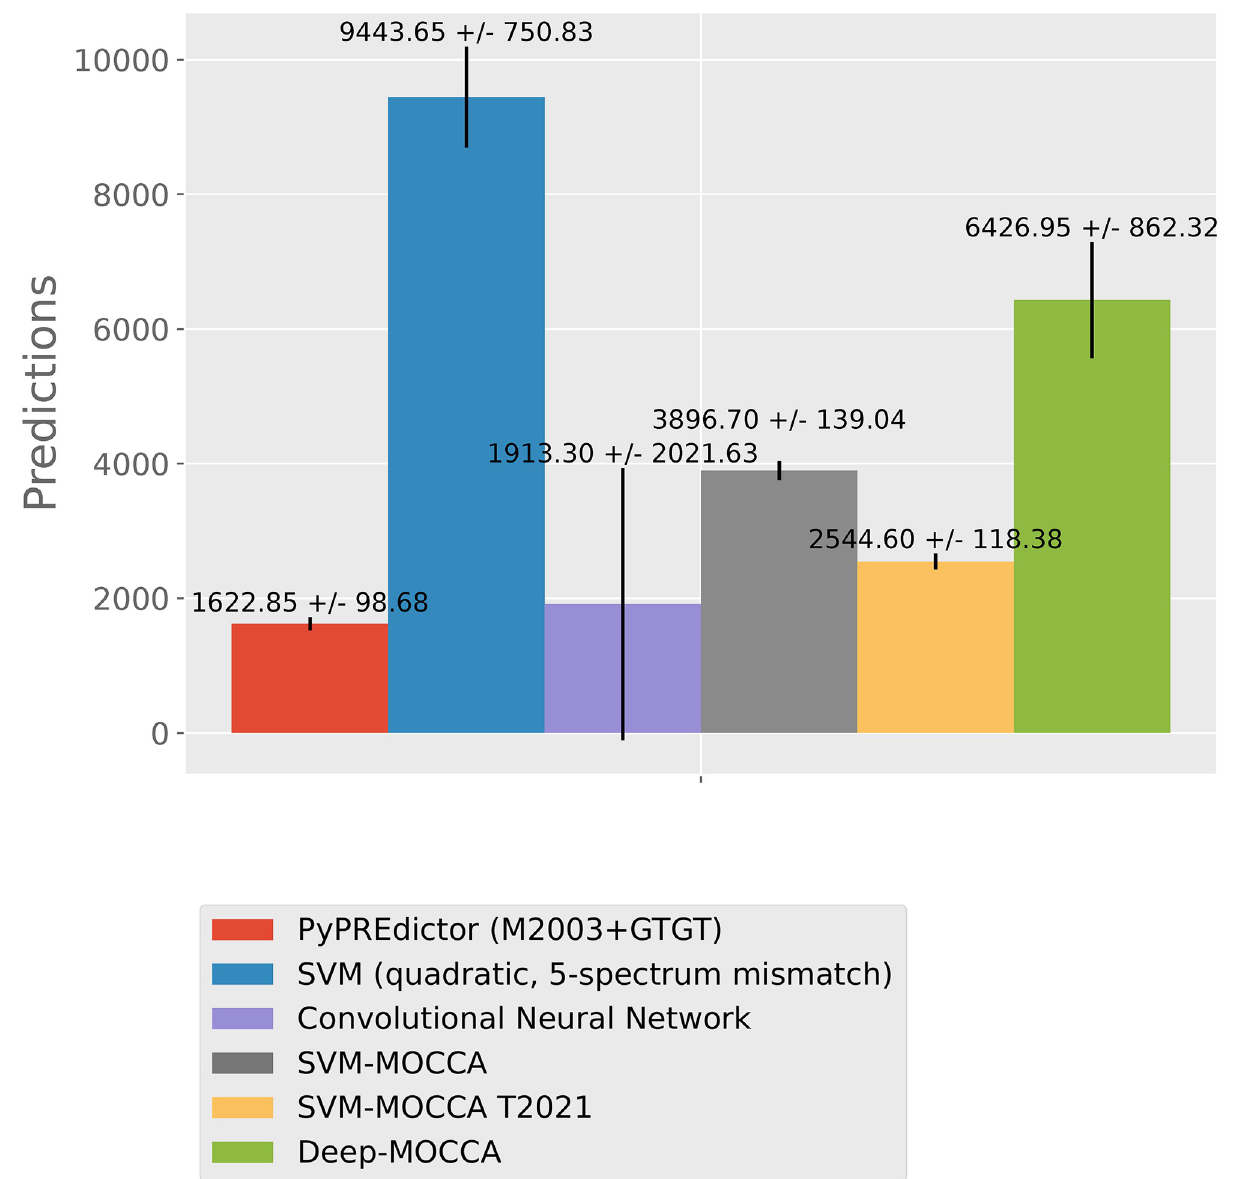
Fig 3. Numbers of